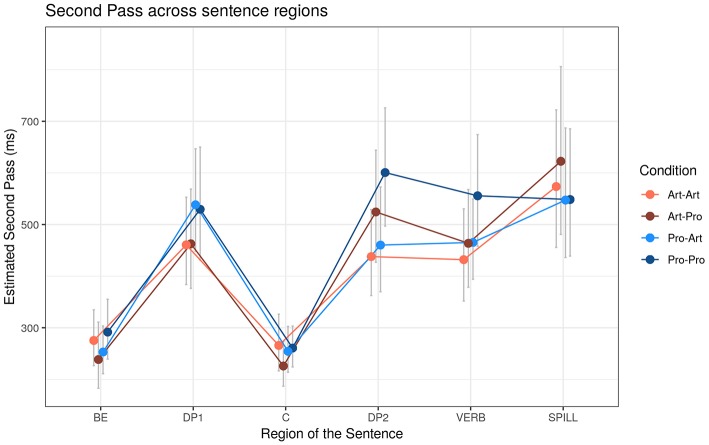
Estimated Total reading Times (TT) (ms) across sentence regions. Error bars represent 95% confidence intervals around the models' estimates.